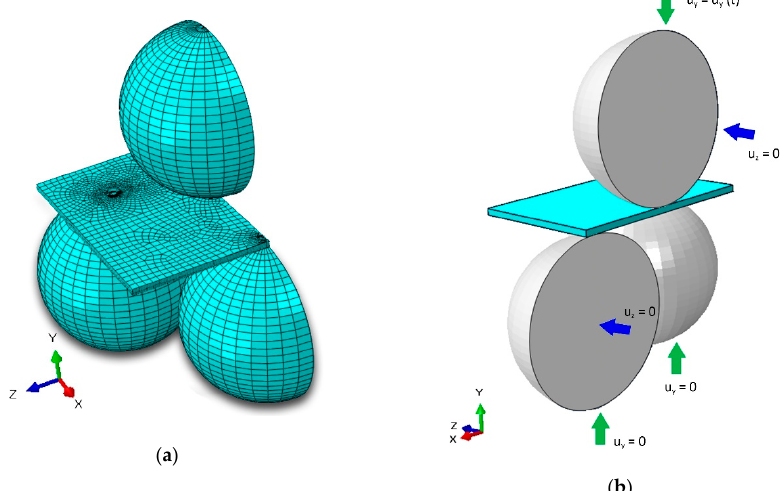
Figure 4. Finite Element (FE)-model example of the ball on three balls test assembly, half model: ( a ) view of the meshed model, and ( b ) outlined boundary conditions.